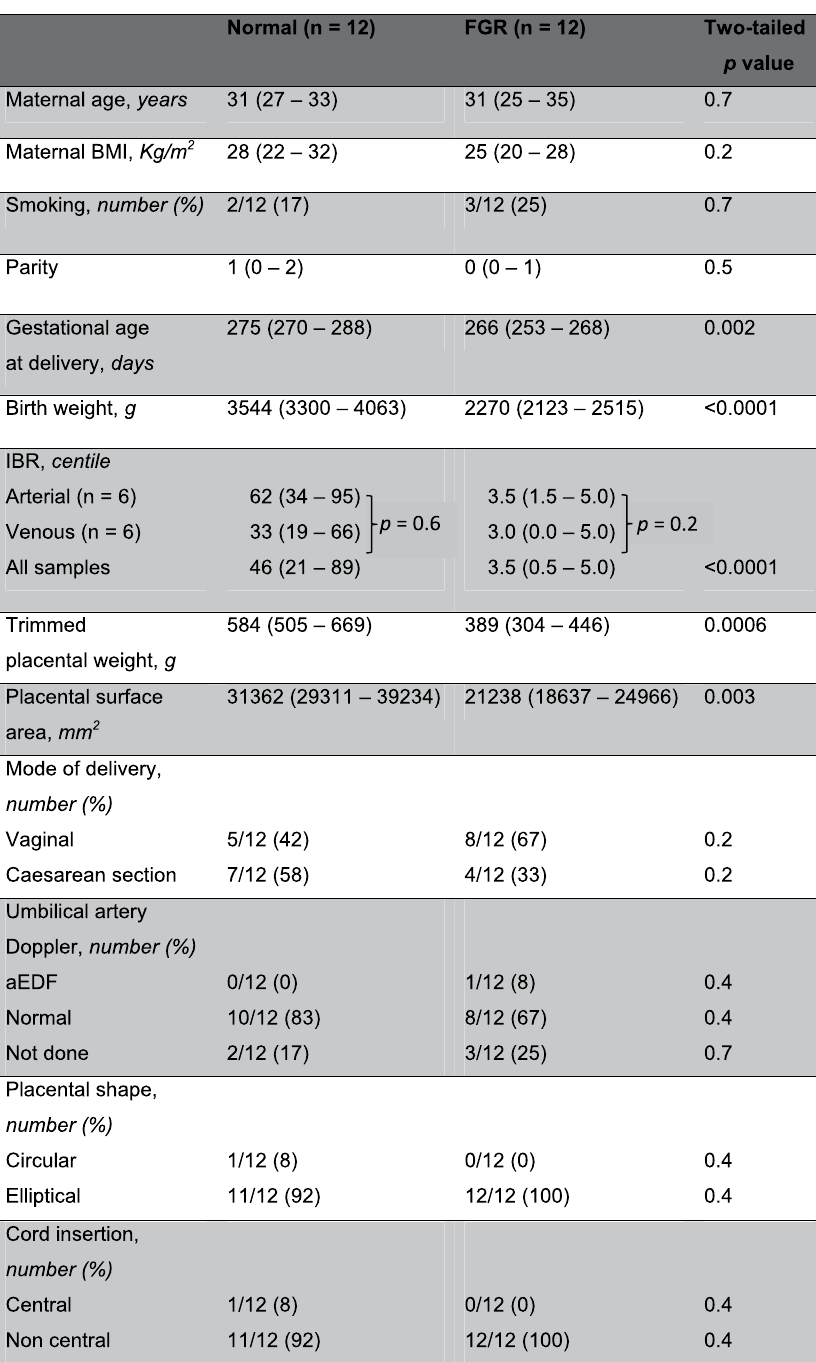
Table 1. Demographic, clinical and gross placental examination details of study participants Data shown are median and interquartile range (IQR) in parenthesis or in a number with percentage in paranthesis as appropriate. p < 0.05 is significant; Mann Whitney U test. BMI, IBR and aEDF represent body mass index, individualised birth weight ratio and absent end diastolic flow respectively. ‘Arterial’ and ‘venous’ refer to the vascular compartments casted for the respective